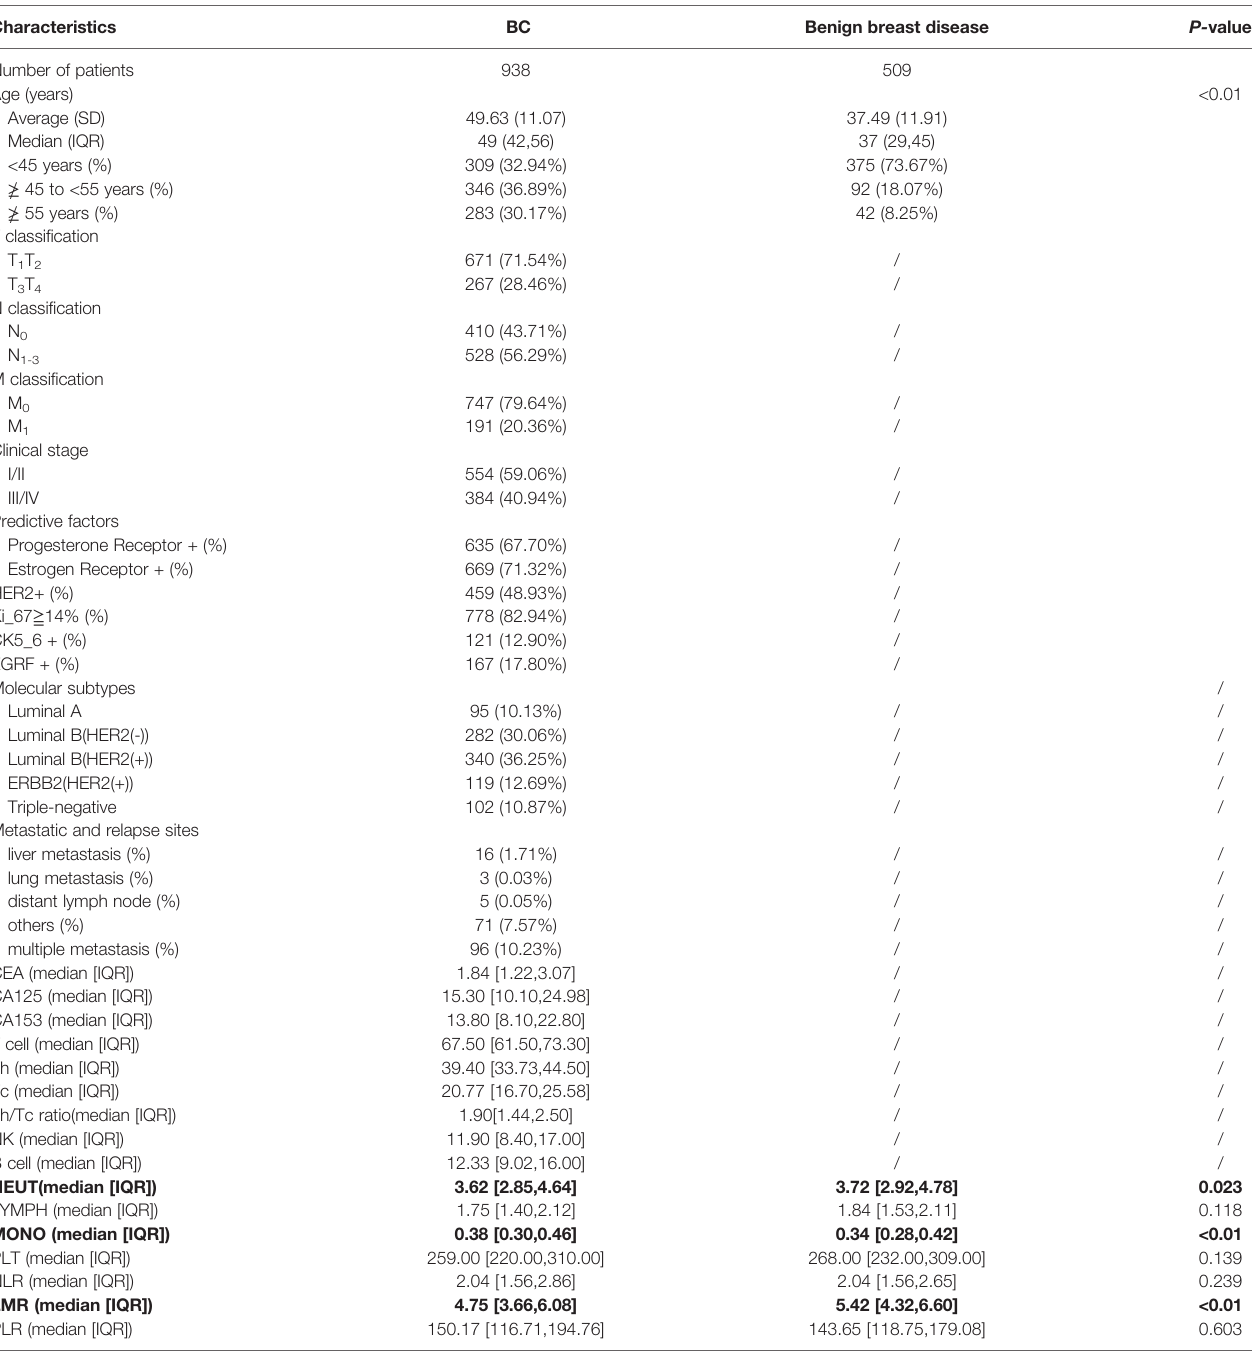
TABLE 1 | Clinicopathological factors and baseline characteristics.